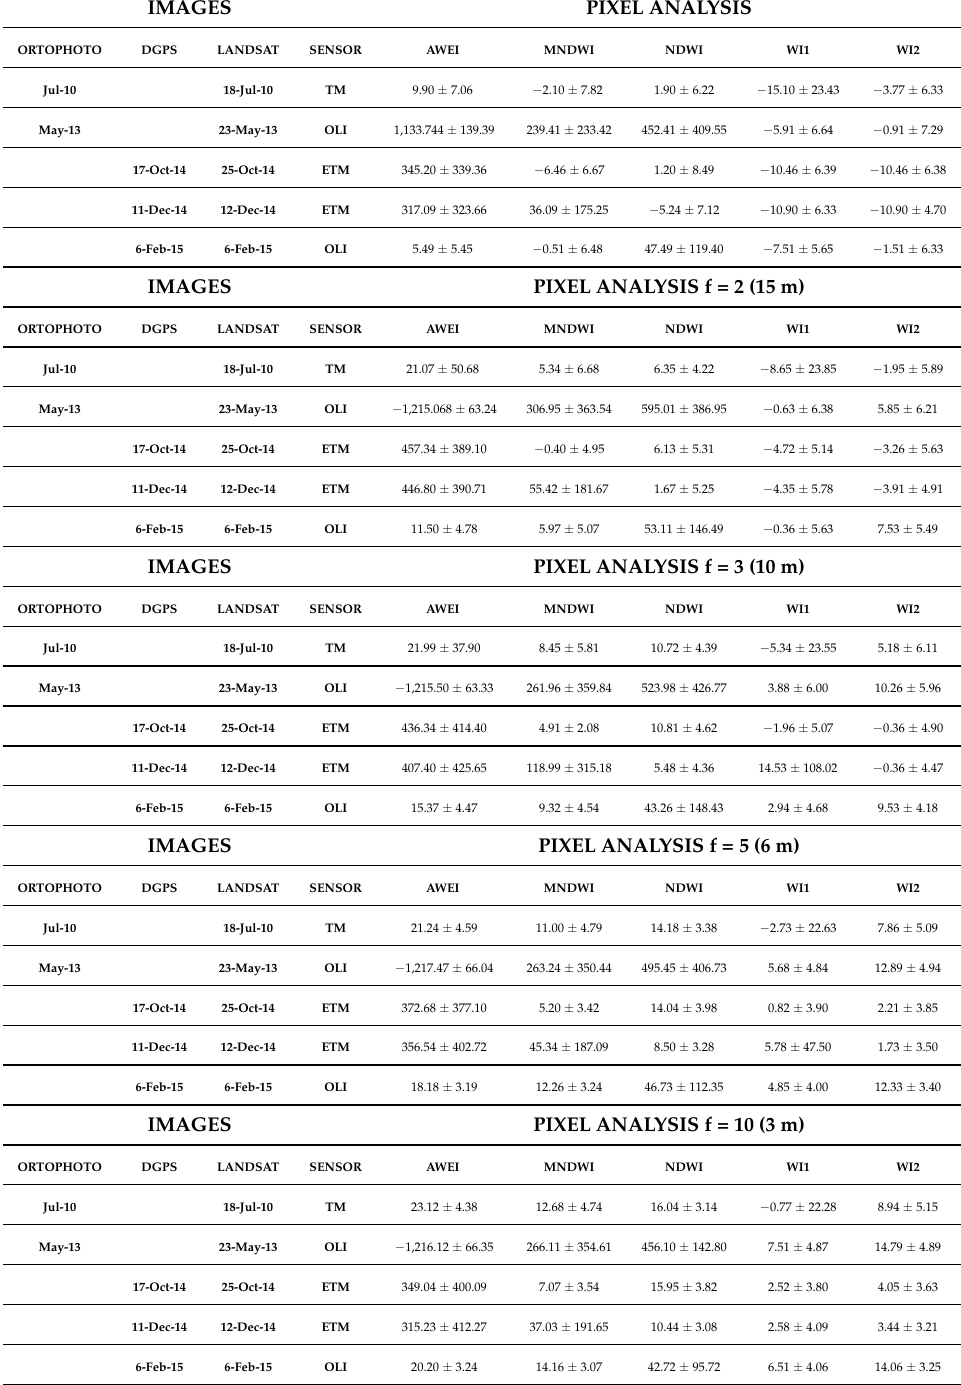
Table A4. Bias comparison (mean ± standard deviation) between Landsat images analyzed and GPS data/high-resolution ortophotos at the pixel level in the Guadalfeo River